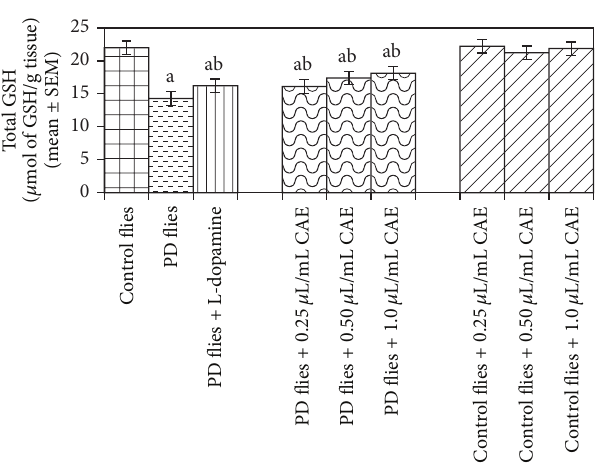
Figure 16: Effect of Centella asiatica extract (CAE) on glutathione (GSH) content measured in the brains of transgenic Drosophila melanogaster after 24 days of the exposure to various treated groups ( a significant with respect to control, 𝑃 -0.01; b significant with respect to PD model flies, 𝑃 -0.05). L-Dopa = 10 −3 M; control flies: UAS- alpha-syn; PD flies: elav-GAL4; UAS-alpha-syn.